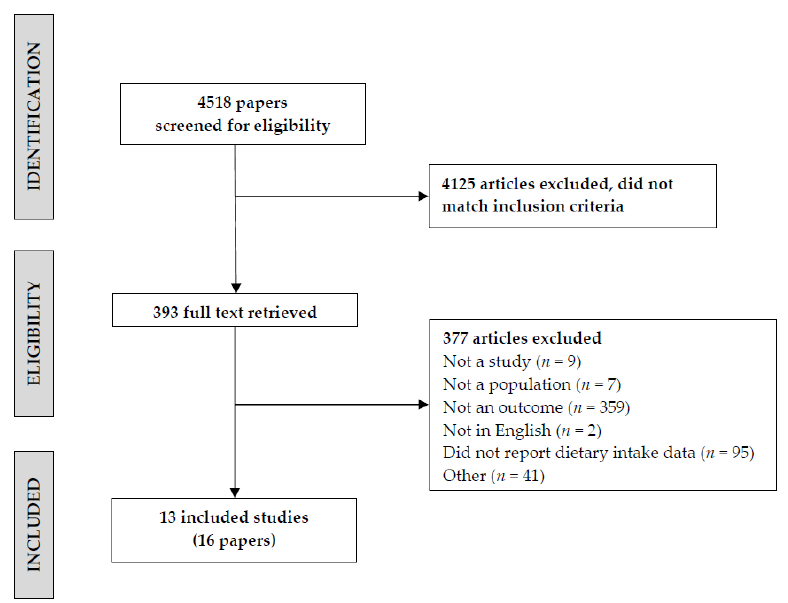
Figure 1. Flow diagram of article identification retrieval and inclusion for the systematic review.